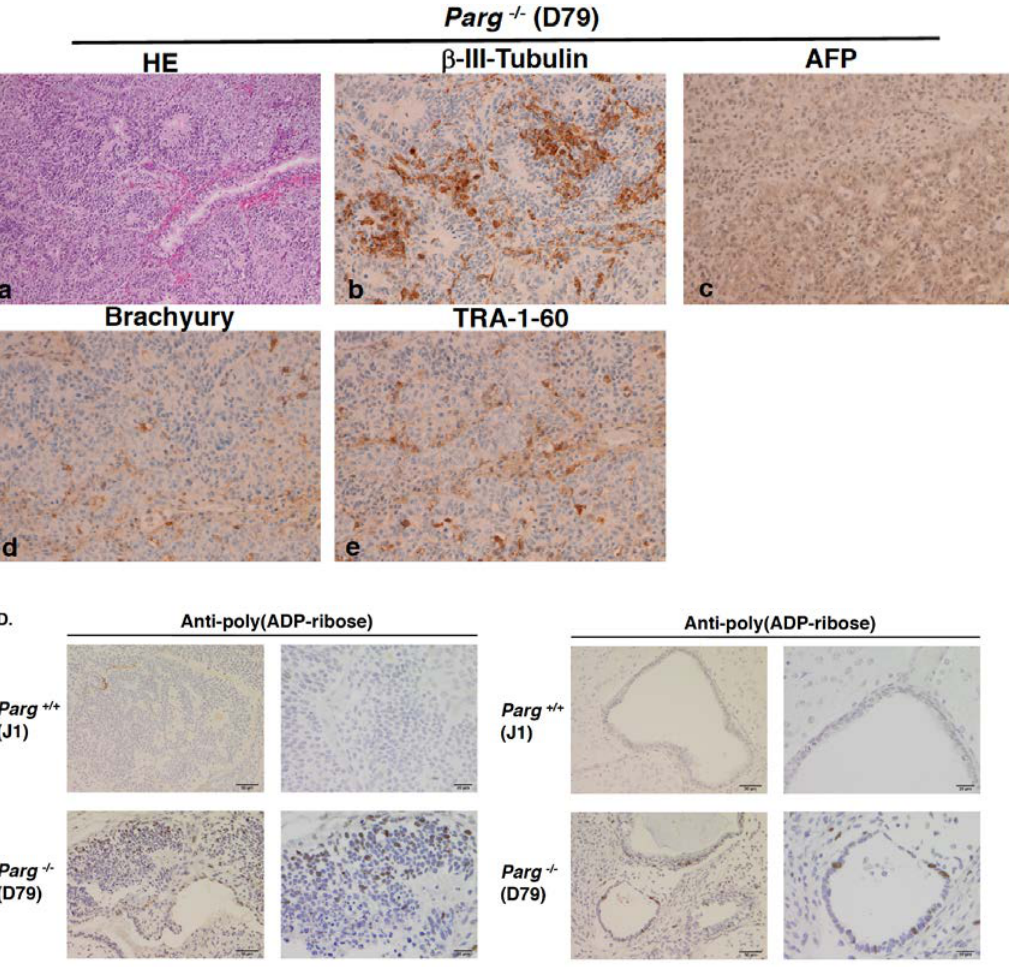
Figure 2. Hematoxylin-eosinstainingoftumortissuesderivedfrommouseEScells. ( A )Hematoxylin-eosin staining of tumor tissues derived from mouse ES cells 1 and 2 weeks after injection. Upper panels, wild-type J1. Lower panels, Parg − / − . ( B ) The left graph shows the percentage of hyperchromatic area of the tumors 4 weeks after injection. Percentage of hematoxylin-positive hyperchromatic area in the total area of tumor section was measured for each tumor. * p < 0.01, ** p < 0.005. Right panels show the typical hyperchromatic areas of hematoxylin-eosin staining of tumors 4 weeks after injection. Upper panels, × 20 magnification (Squares show magnified regions in the lower panels. Lower panels, × 40 magnification. The tumors showed heterogeneous cell components containing primitive neuroepithelial components and embryonal carcinoma components. ( C ) HE staining and immunostaining of the tumors at 4 weeks with antibodies against b-III-tubulin, ectoderm marker; AFP, endoderm marker ( × 20 magnification). Hematoxylin-eosin staining, × 10 magnification. The mixed staining pattern of ectodermal and endodermal markers was observed in hyperchromatic regions of Parg − / − tumors at 4 weeks. ( D ) Immunostaining of the tumors at 4 weeks after injection with antibody against anti-PAR. Right panels in D are magnified images, Bars, 50 mm (left panels in D), 20 mm (right panels in D). PAR staining was observed occasionally in the cell nuclei in the Parg − / − tumor but not in the Parg +/+